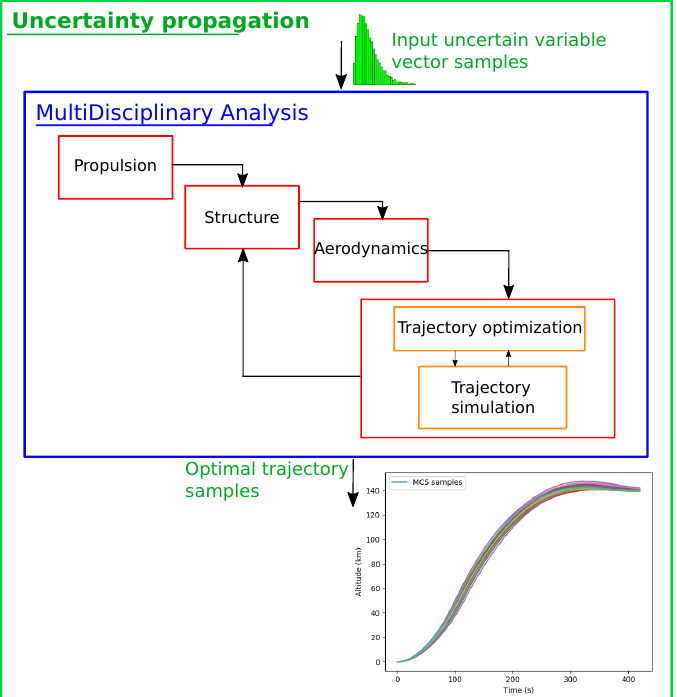
Figure 12. Uncertainty propagation for launch vehicle design test case using multidisciplinary simulation.